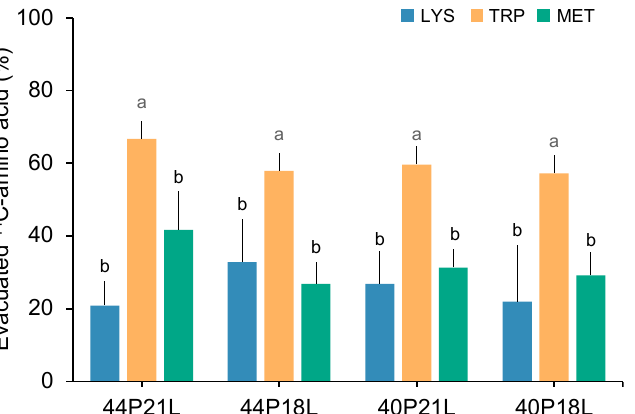
Figure 1. Proportion (%) of the total recovered 14 C-amino acids lysine (LYS), tryptophan (TRP) and methionine (MET) that was evacuated in gilthead seabream juveniles fed 44P21L, 44P18L, 40P21L, or 40P18L diets. Values are presented as means ± standard deviation ( n = 6 fish for each diet and tracer). Letters (a and b) represent significant differences among amino acids’ metabolic fate as a function of their nature (two-way ANOVA followed by Tukey’s multiple-comparison test, p < 0.05). The amino acid retention in the gut (Figure 2a) was affected by the diet formulations, although post-hoc tests did not determine which treatments were significantly different. In general, fish that were fed the 40P21L and the 40P18L diets presented higher retention values for all amino acids than the fish that were fed the high protein diets. Additionally, the nature of the amino acid influenced their retention in this tissue. Lysine was signifi- cantly more retained than methionine in all dietary treatments. Tryptophan retention in the gut was similar to lysine or methionine.